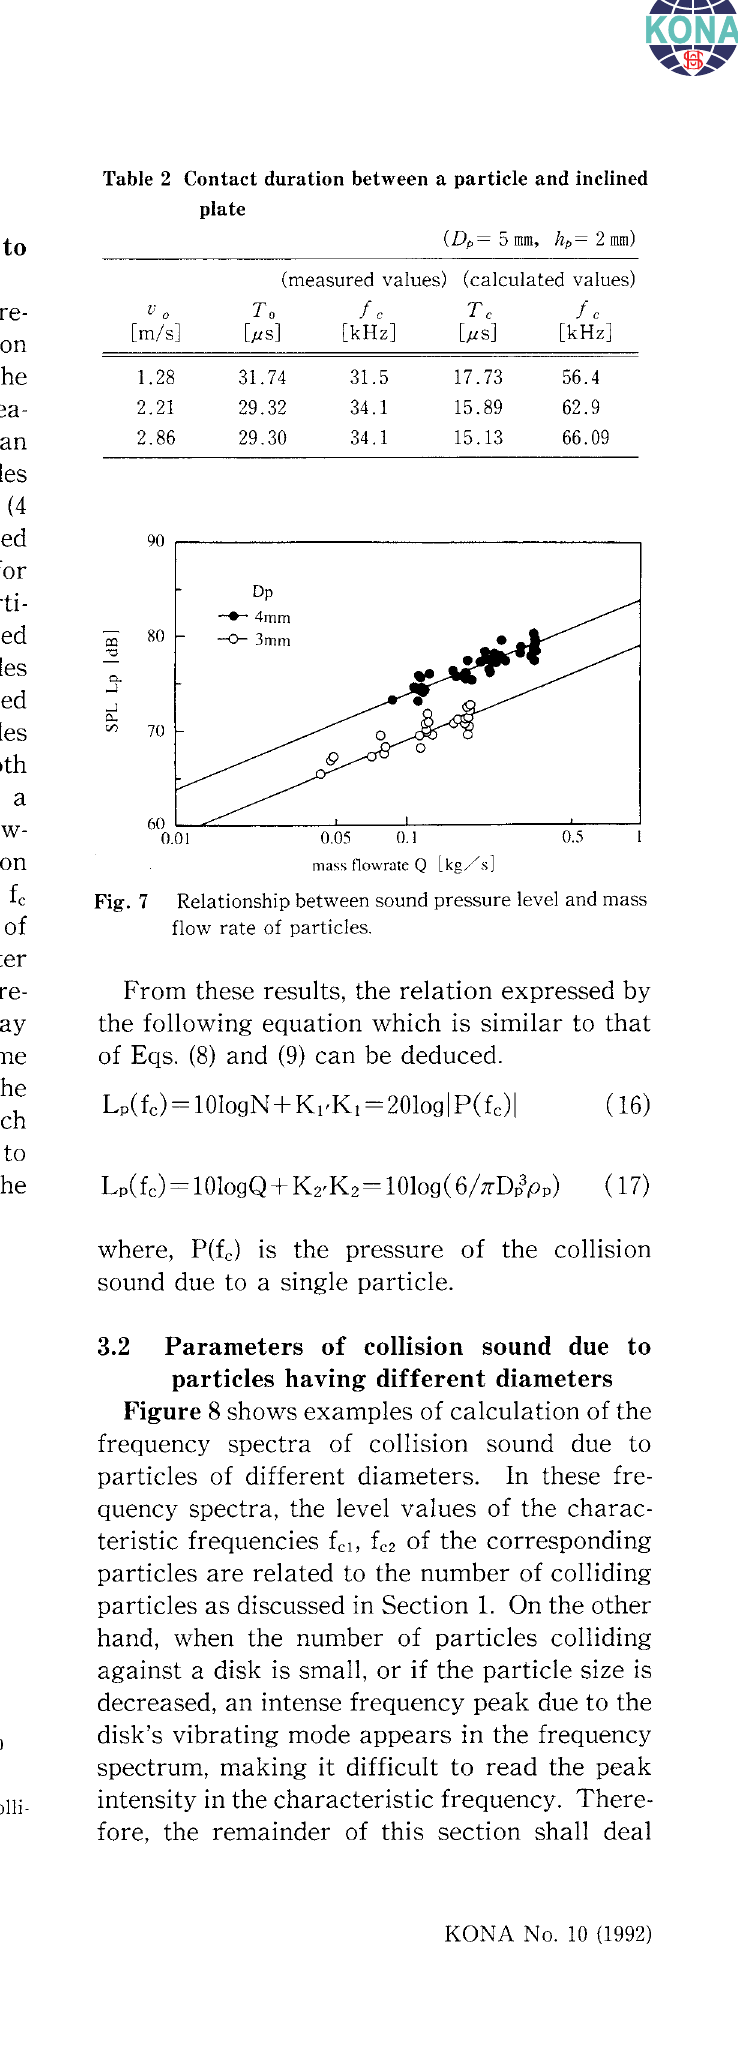
Fig. 6 Frequency spectra of the sound radiated from colli sion of uniform particles.